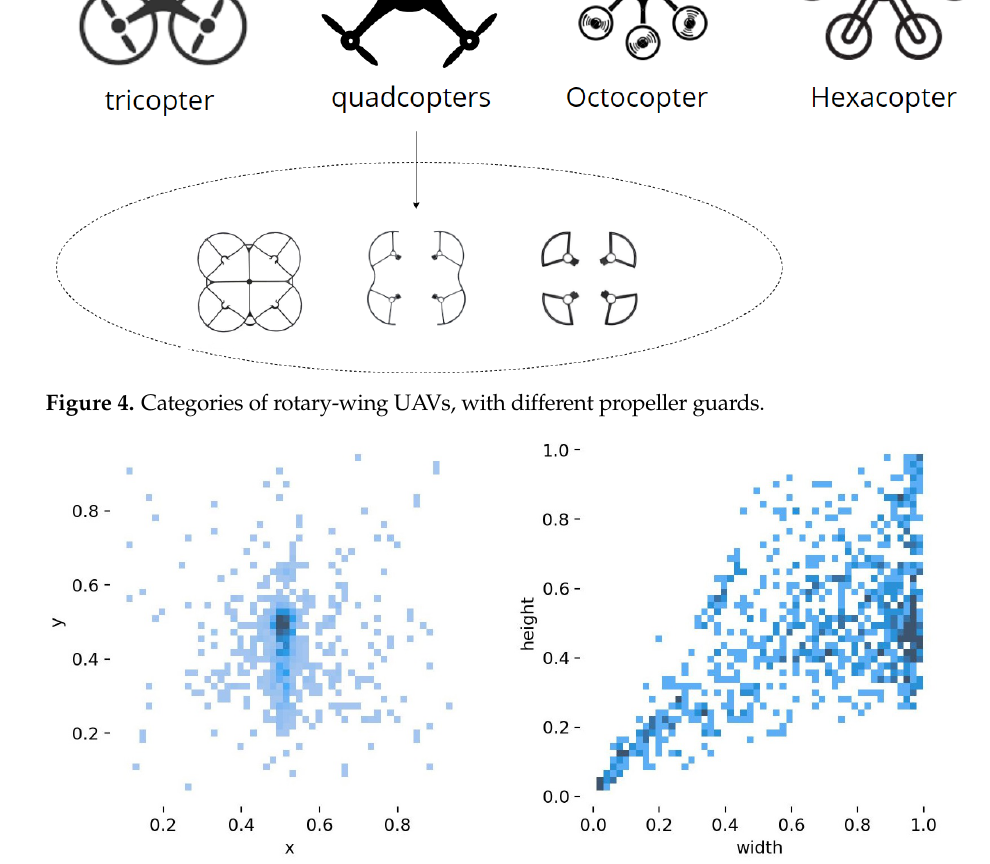
Figure 5. Distribution of the sizes and locations of drone objects in images of the